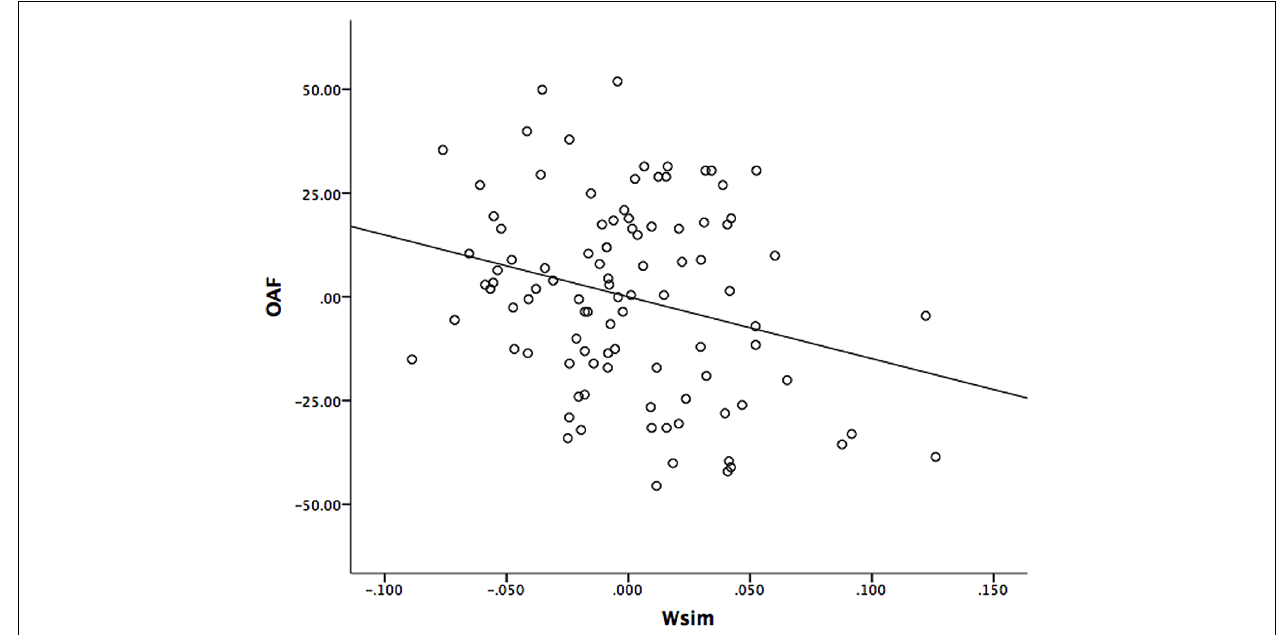
FIGURE 2 | Partial regression plot of OAF against w sim . The plot illustrates the partial correlation between OAF and w sim after the linear effects of Ravens’ is removed.